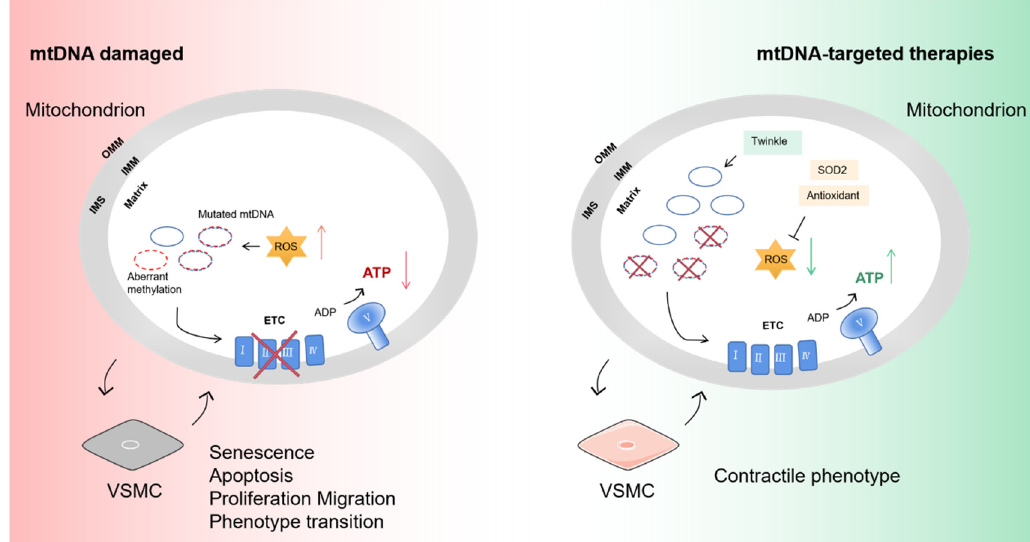
Figure 4. The influence of mtDNA damage on VSMCs and targeted therapies. mtDNA encodes core subunits of respiratory chain complexes I, III and IV and ATP synthase. Pathogenic mutation and aberrant methylation of mtDNA affect oxidative respiratory function. Reduced ATP and increased mtROS drive the senescence of VSMC and phenotype transition from contractile to non-contractile (synthetic). Overexpression of Twinkle increases the mtDNA copy number to shift the heterogeneity level of mutation. Administration of the SOD2 activator and antioxidants can counteract excess mtROS and restore mitochondrial homeostasis. SOD2, superoxide dismutase 2. Part of the elements in this figure are using resources from Servier Medical Art under a Creative Commons Attribution license.